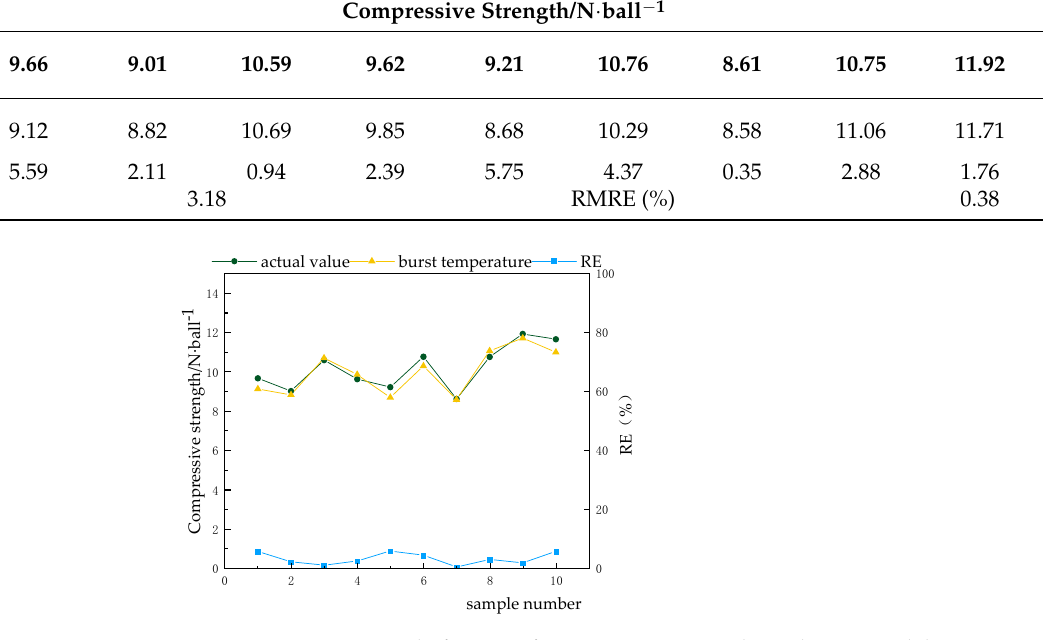
Figure 9. Variation trend of the error of the falling intensity prediction model.